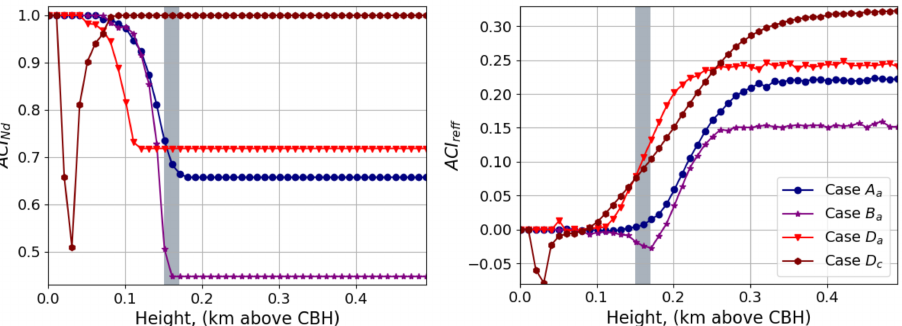
Figure 9. Aerosol cloud interaction index ( ACI Nd and ACI ref f ) for different aerosol types, as a function of height, according to the legend.